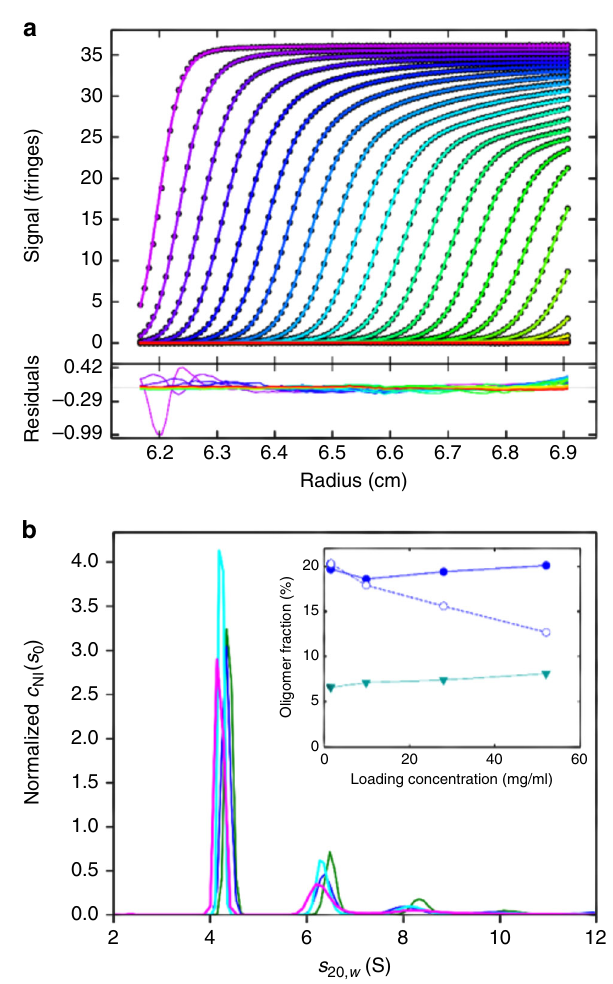
Fig. 5 Sedimentation analysis of BSA at 52 mg/ml in PBS. a Interference optical data were acquired in a 3 mm centerpiece (circles, showing every 10th data point of every third scan). The best- fi t c NI ( s 0 ) model (solid lines) with a fi xed frictional ratio of 1.45 results in an rmsd of 0.058 fringes, with k = 8.4 ml/g and k = 10 ml/g. b The associated sedimentation coef fi cient S D distribution at 52 mg/ml (magenta) and, for comparison, the distributions obtained in analogous analyses at 28 mg/ml (cyan), 9.8 mg/ml (blue), both also acquired in 3 mm centerpieces, and 1.6 mg/ml (green) acquired in a 12 mm centerpiece. The inset shows integrated dimer fractions at ~6.5 S (solid blue circles) and trimer fractions at ~8 S (solid green triangles) from these c NI ( s 0 ) analysis accounting for nonideality. The open circles are the apparent dimer fractions from empirical c ( s ) analyses of the same data neglecting nonideality contributions (Supplementary Fig.